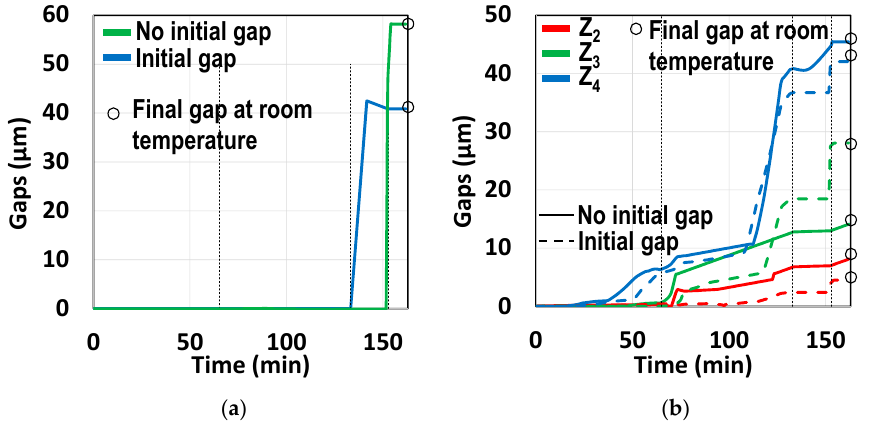
Figure 11. Evolution of the gaps during annealing. ( a ) Z 1 at the top of the electrode, ( b ) Z 2 , Z 3 , and Z 4 along the electrode’s axis.